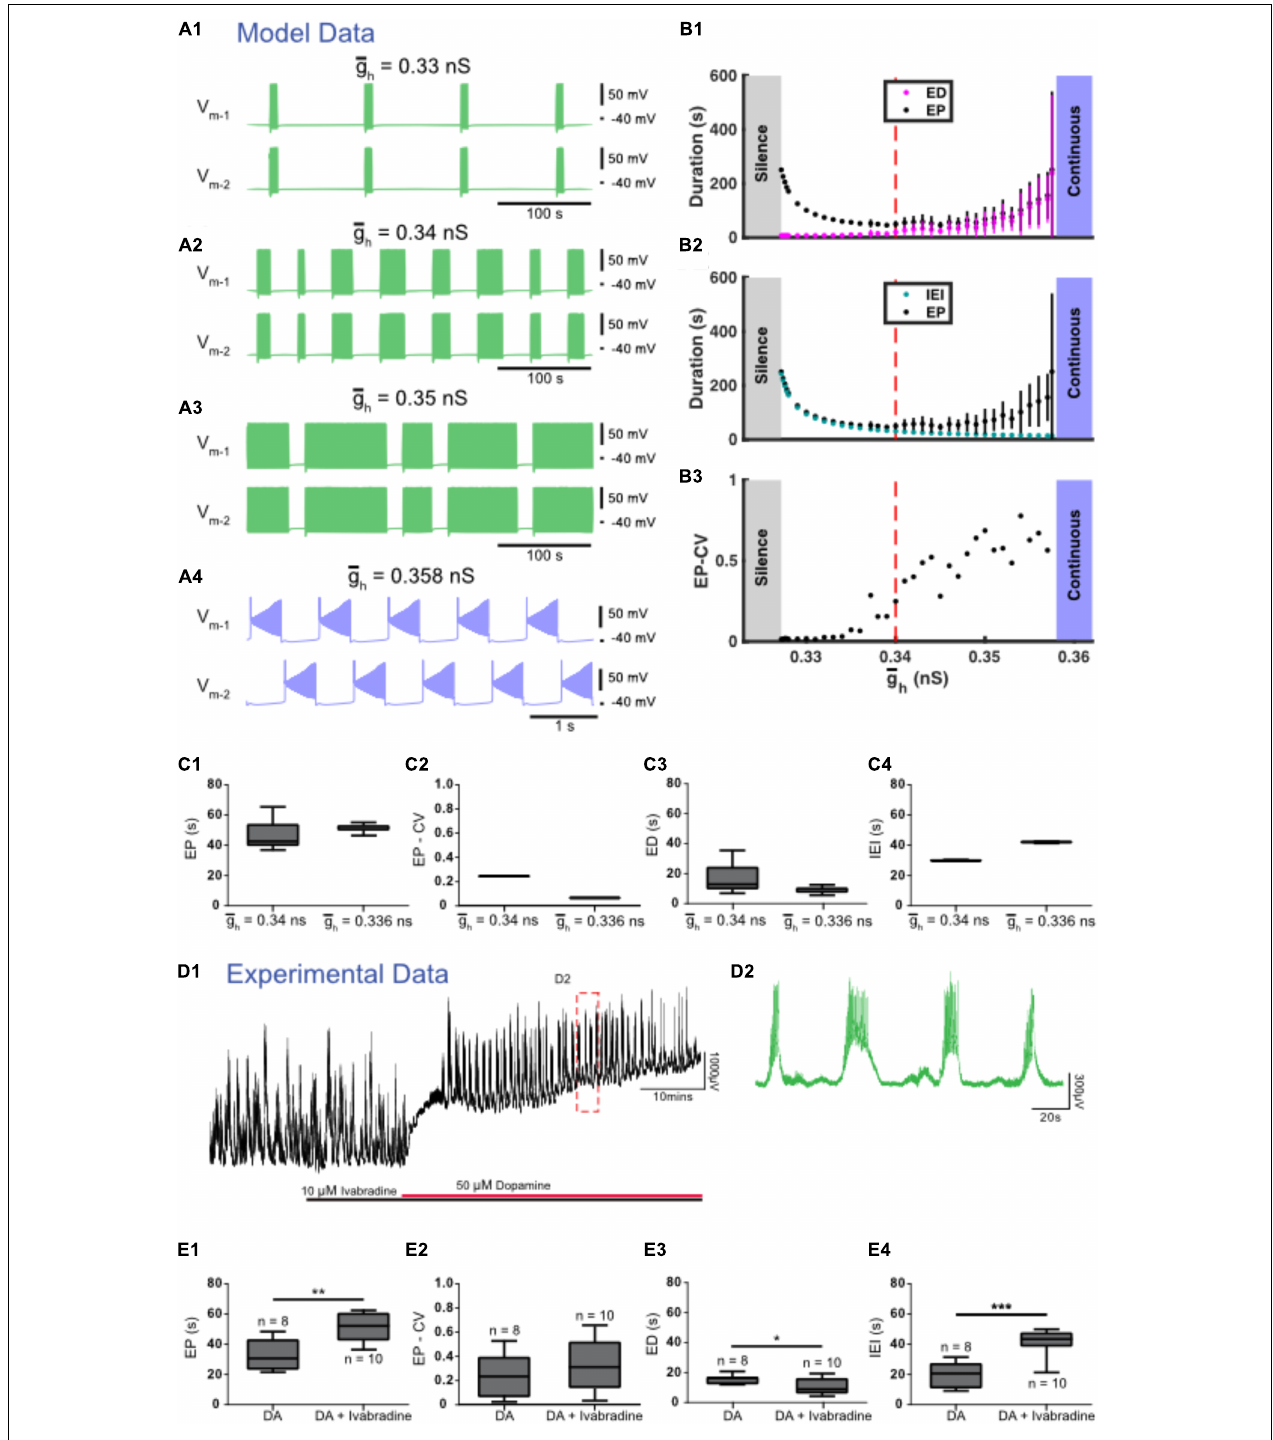
FIGURE 5 | Regulation of g h accurately predicts the effects of experimental blockade of I h with ivabradine. (A) Examples of various types of activity produced at different values of the maximal conductance of I h ( g h ) are depicted. Episodic activity occurs at g h = 0.33 nS (A1) , at g h = 0.34 nS (canonical) (A2) , and at g h = 0.35 nS (A3) , where episode duration (ED) increased and interepisode interval (IEI) decreased as g h increased. (A4) Continuous bursting occurred at g h = 0.358 nS. (B) Episodic activity properties and a transition to continuous activity depend on g h . (B1) Mean episode period (EP) (black dots) and mean ED (magenta dots) increased exponentially as g h increased. (B2) Mean IEI (cyan dots) increased exponentially as g h decreased. (B3) Mean EP-CV (black dots) increased with g h . (C) Box and whisker plots depict interquartile range (boxes), median (horizontal black lines), maximum and minimum values in the data range (whiskers). (C1) When g h was decreased, EP